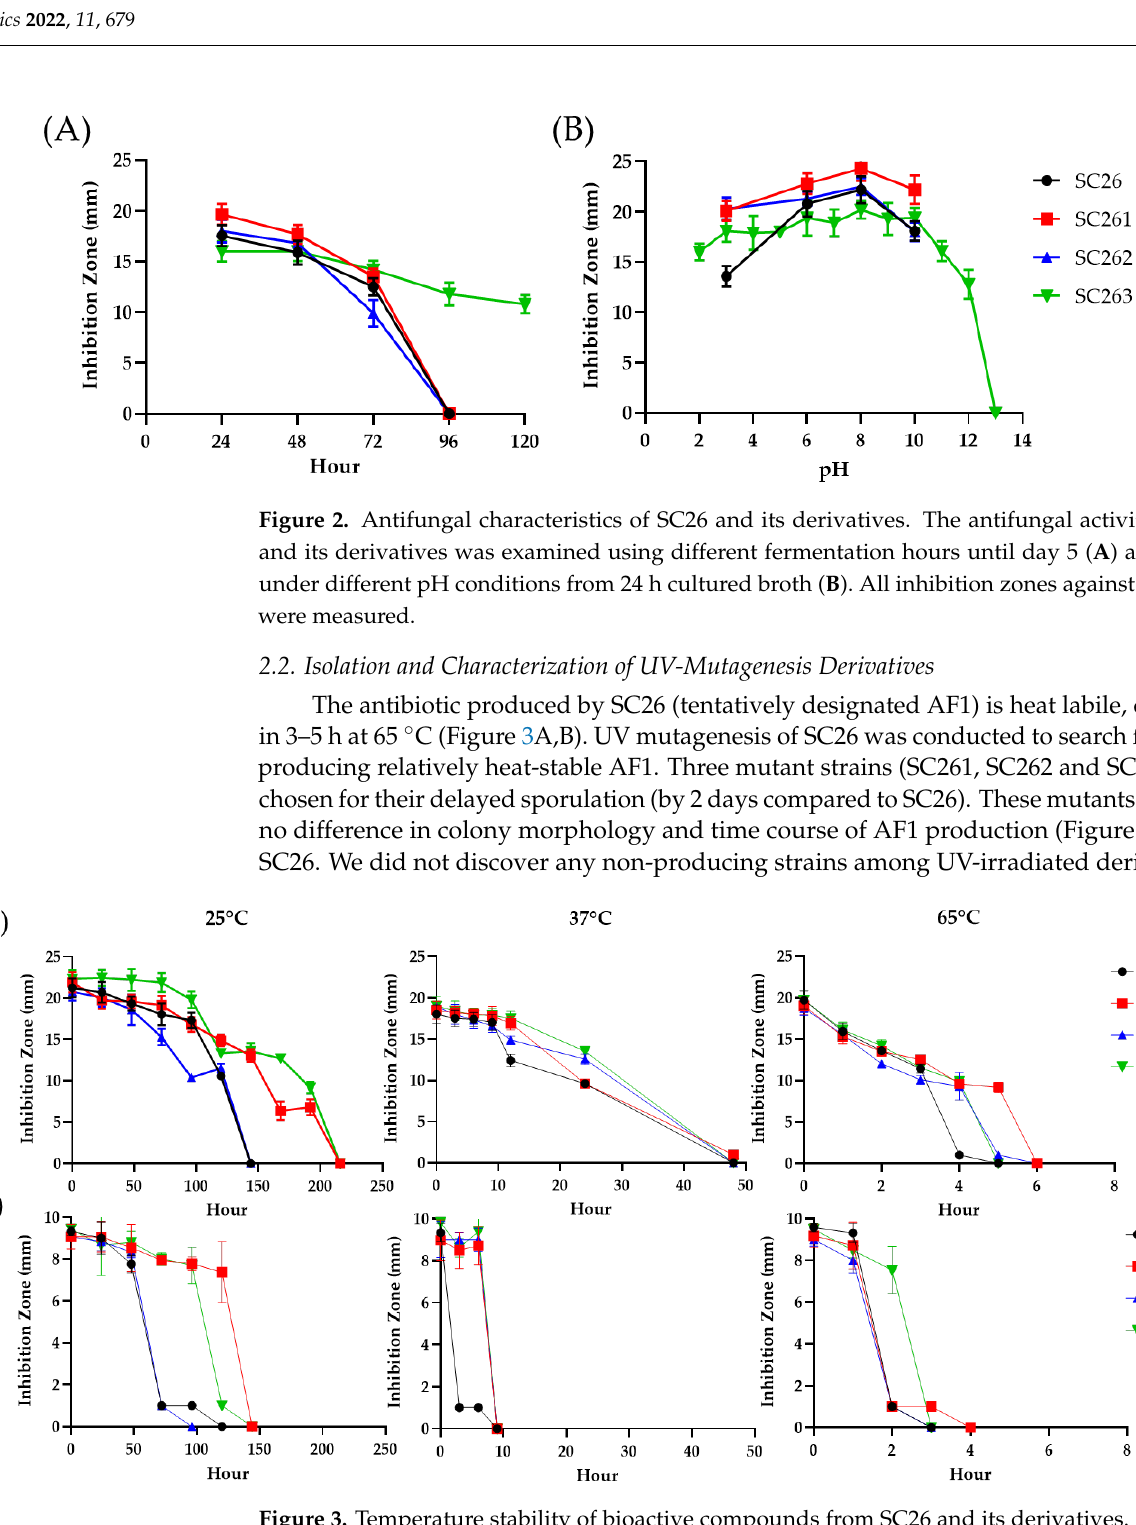
Figure 3. Temperature stability of bioactive compounds from SC26 and its derivatives. Overnight cultured broths from SC26 and its three derivatives (SC261, SC262 and SC263) were stored at 25 °C, 37 °C and 65 °C. Antimicrobial activity against C. albicans ( A ) and S. aureus ( B ) was measured at different time points.